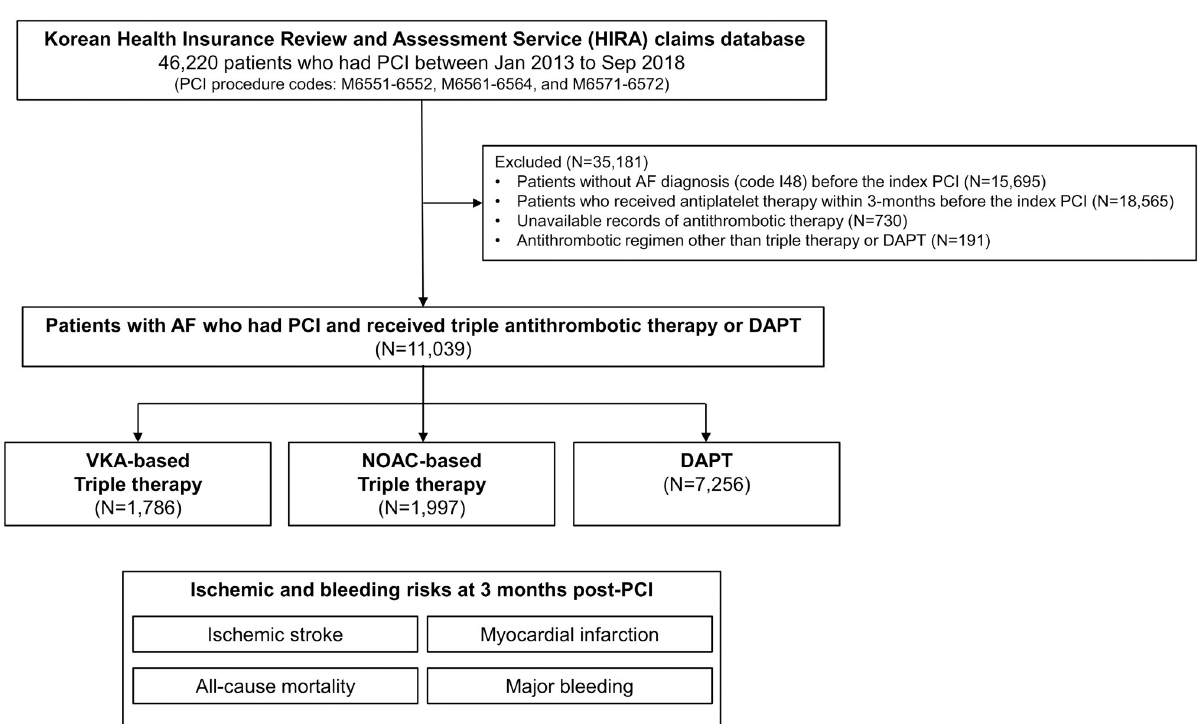
Fig 1. Study flow. Patients who underwent PCI between 2013 and 2018 (N = 46,220) were screened from the HIRA claims database. We excluded patients who were not diagnosed for AF before the index PCI and those who received any platelet inhibitor within 3-month before the index PCI. After additional exclusion of patients with antithrombotic regimens other than triple therapy or DAPT at baseline and those who died before discharge, a total of 11,039 patients were finally included. AF, atrial fibrillation; DAPT, dual antiplatelet therapy; NOAC, non-vitamin K oral anticoagulant; PCI, percutaneous coronary intervention; VKA, vitamin K